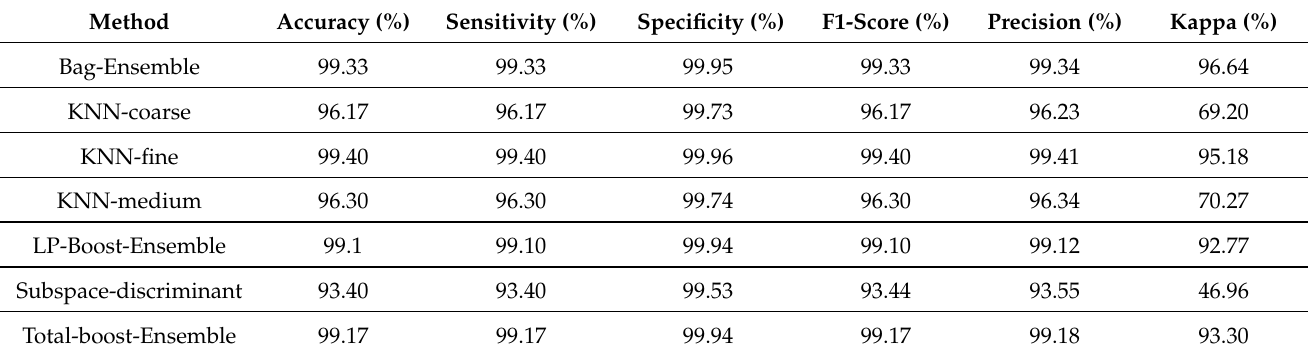
Table 6. Classification validation accuracy of fivefold validation using self-activated